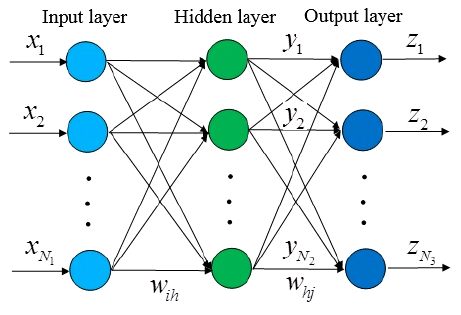
Figure 5. Topology of MLP neural network structure.